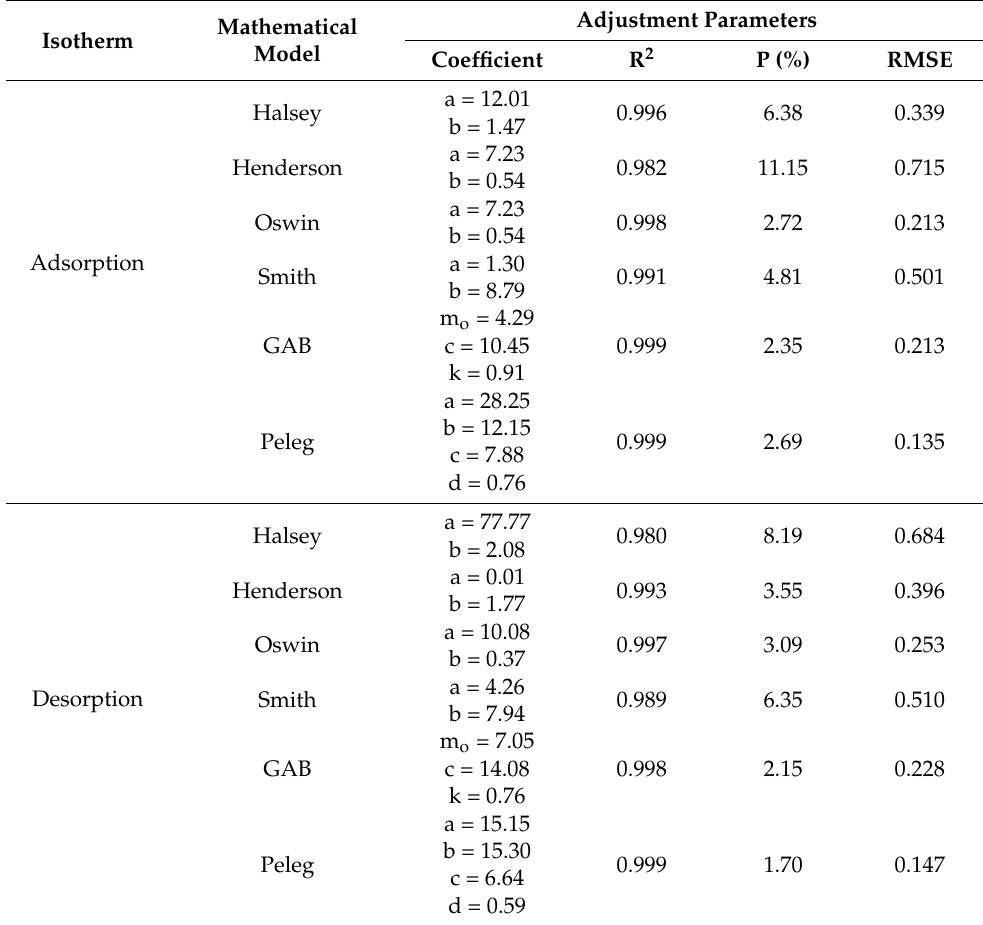
Table 4. Statistics and model’s coefficients for mathematical modeling of moisture sorption data of dried purple basil leaves at 25 ◦